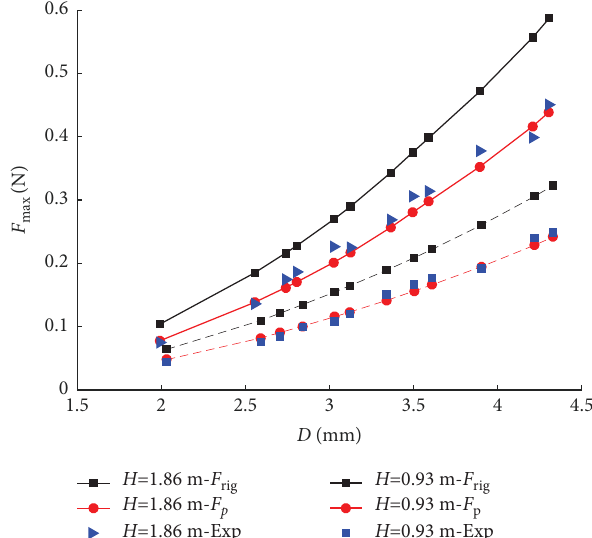
Figure 23: Comparison chart of maximum impact load.